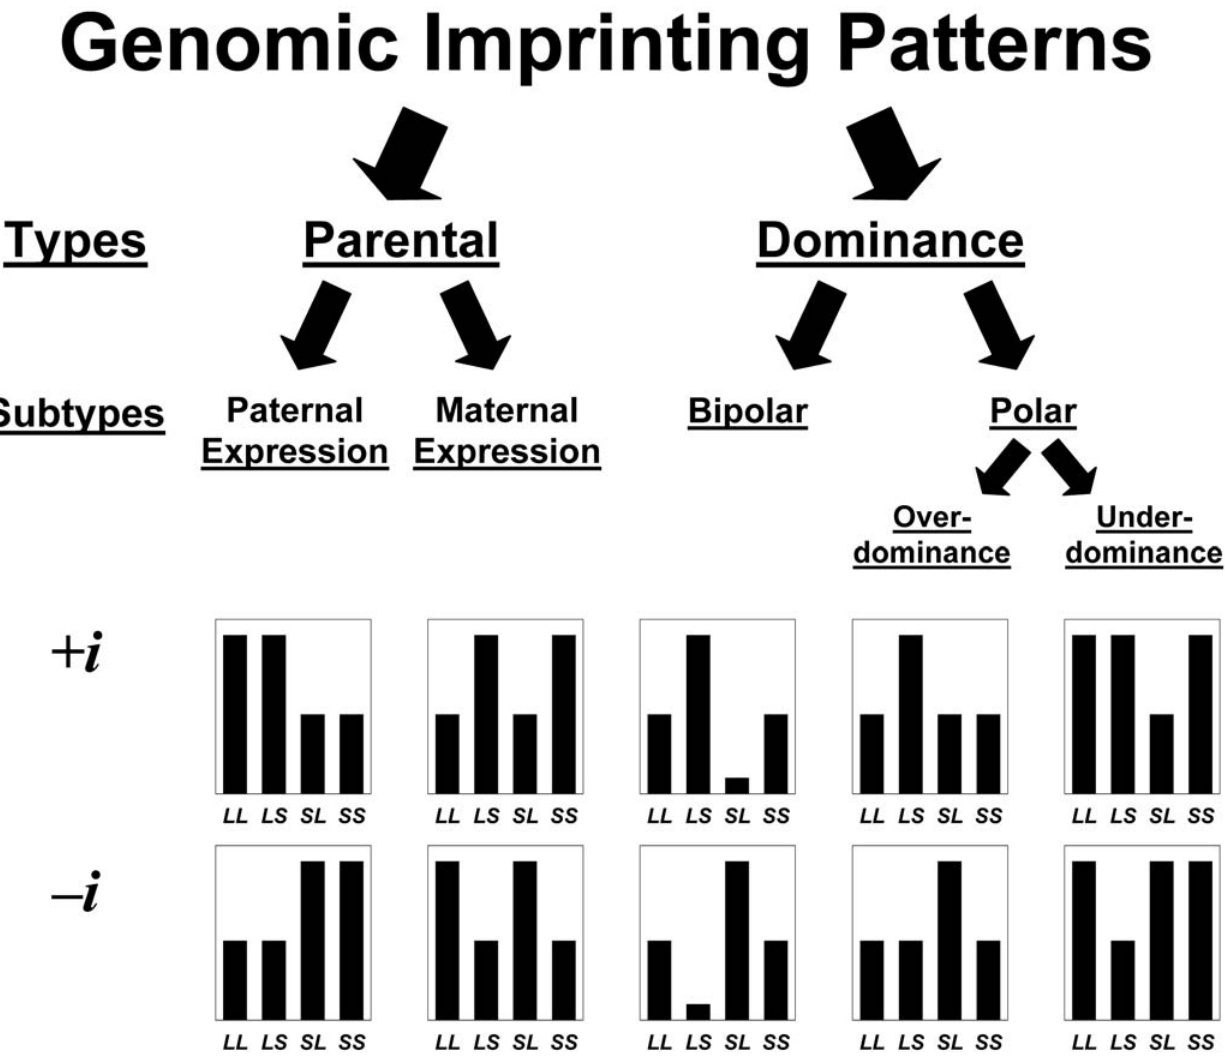
Figure 1. All possible phenotypic patterns of genomic imprinting. Two principal patterns are possible: parental expression and dominance imprinting. Parental expression has two subtypes describing which allele is being expressed (paternal versus maternal). Dominance imprinting refers to the case where the two homozygotes are the same while the heterozygotes are different from each other. There are two subtypes of dominance imprinting: bipolar and polar. Bipolar dominance refers to the case where one heterozygote is larger than the homozygotes while the other heterozygote is smaller (i.e., one heterozygote shows overdominance while the other shows underdominance). Polar dominance refers to the case where one heterozygote is the same as the two homozygotes while the other heterozygote is not. Polar dominance may show overdominance, where the heterozygote differing from the other three genotypes is larger, or underdominance, where it is smaller. The plots give examples of the expected pattern of phenotypes for the four ordered genotypes when the sign of i is either positive or